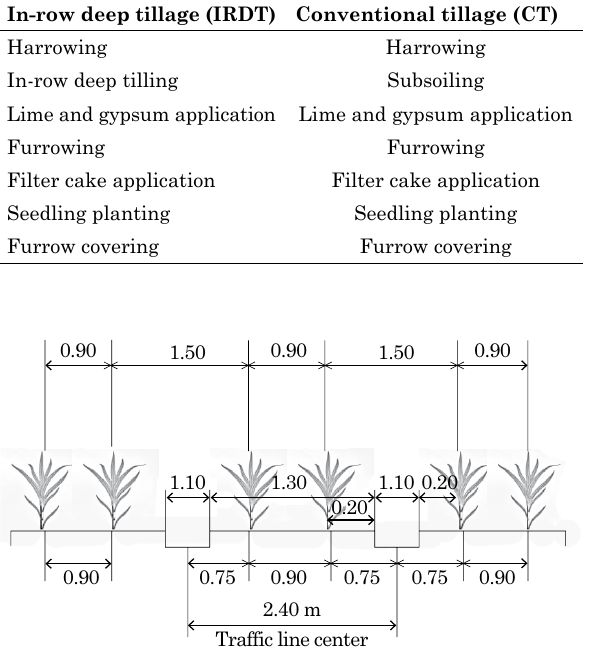
figure 1. Sugarcane spacing in this experiment in two soil tillage treatments: in-row deep tillage and Conventional